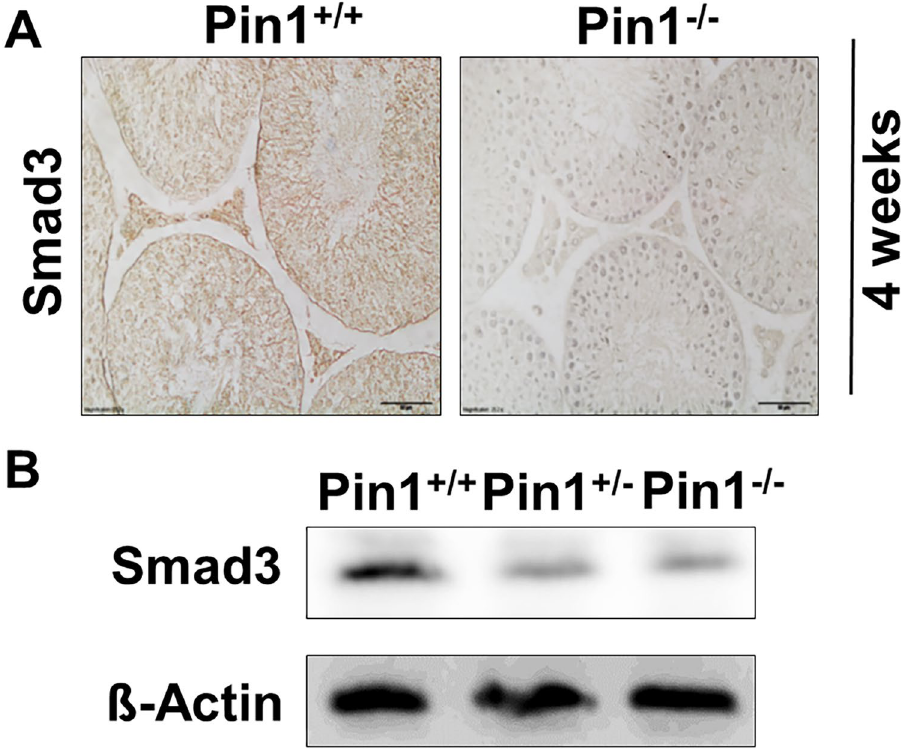
Figure 5. Smad3 expression is decreased in Pin − / − testes. ( A ) Testicular tissues from 4-week-old mice were immunostained for Smad3 protein (scale bar = 50 µ M). ( B ) Quantification of Smad3 expression was performed on isolated Sertoli cells from Pin1 + / + , Pin1 + / − , and Pin1 − / − mice at 4 weeks of age. Freshly isolated cells were lysed in protein lysis buffer immediately after hypotonic shock to remove germ cells. ß-Actin was used as a loading